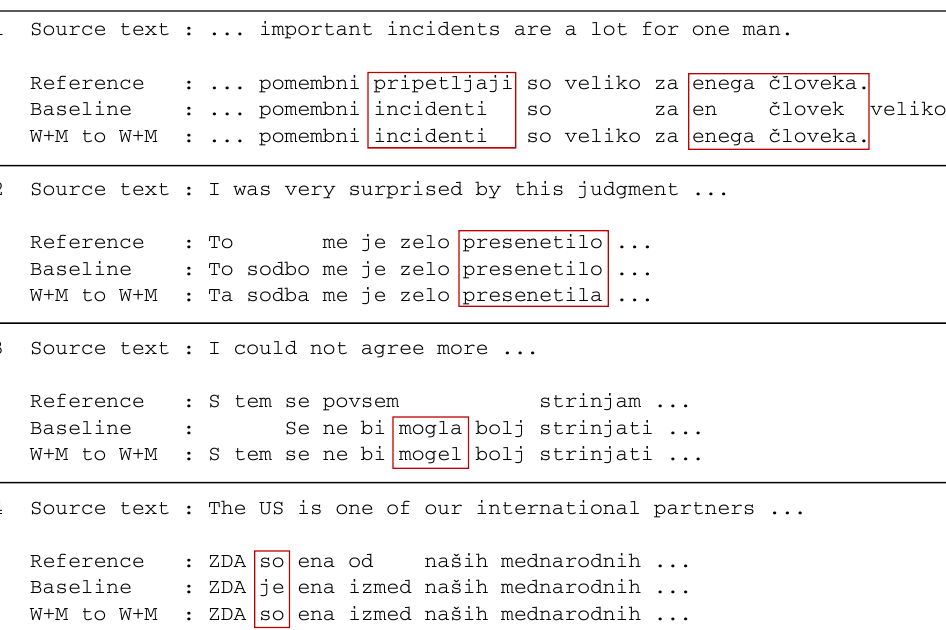
Figure 6. Selected translation examples from English to Slovene with the source text, reference translation, baseline system translation and improved system translation using words and MSD tags (W+M to